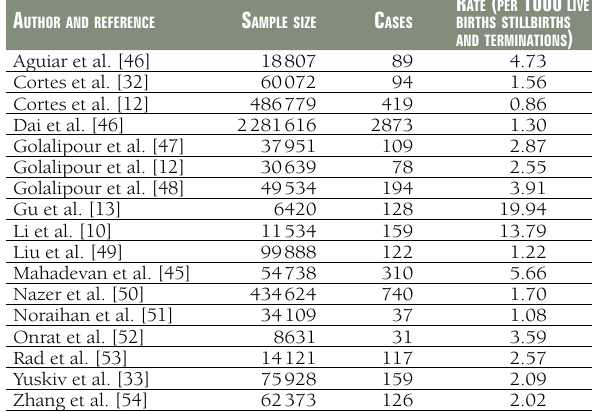
Table 8. Studies that reported rates for total NTD burden based